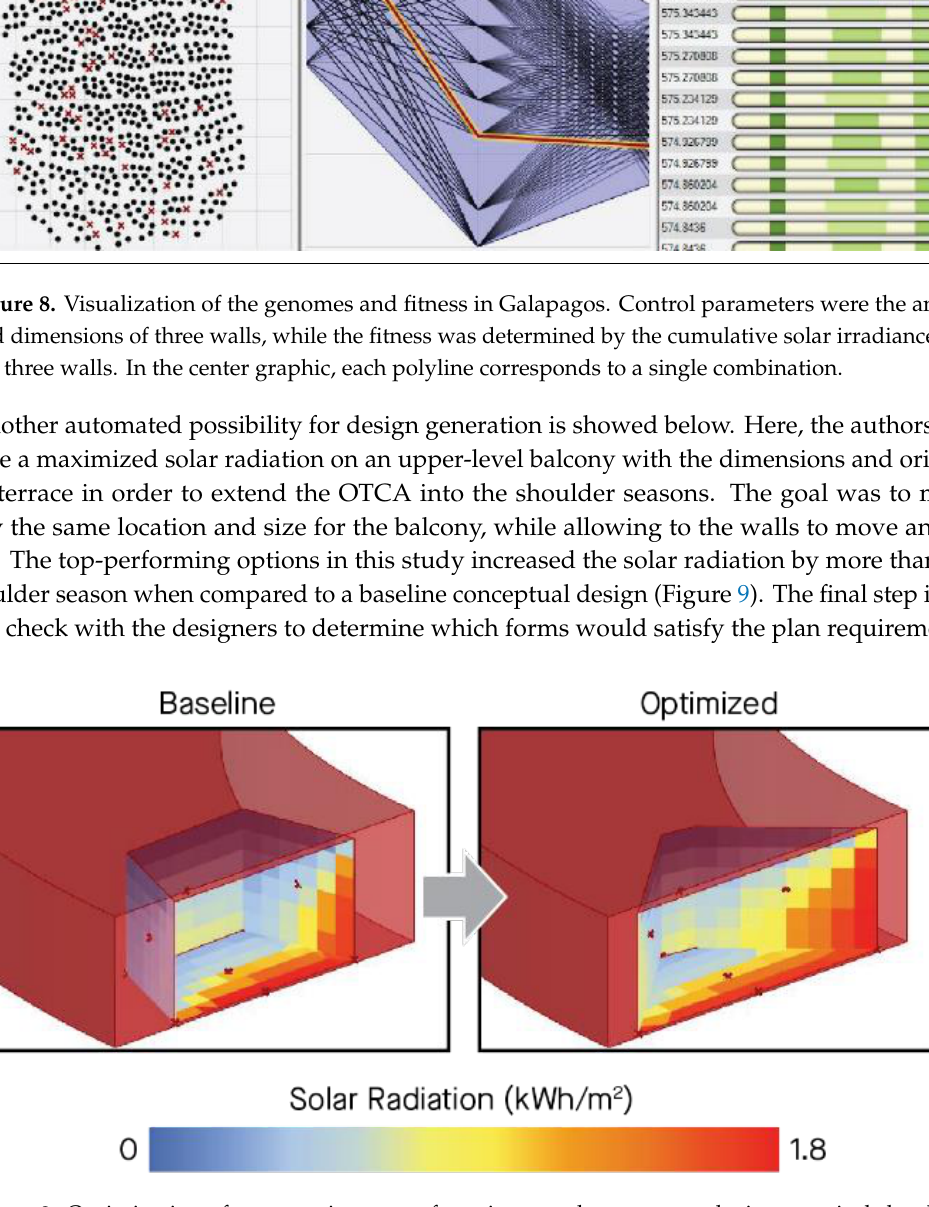
Figure 9. Optimization of a terrace in terms of maximum solar exposure during a typical shoulder season day.